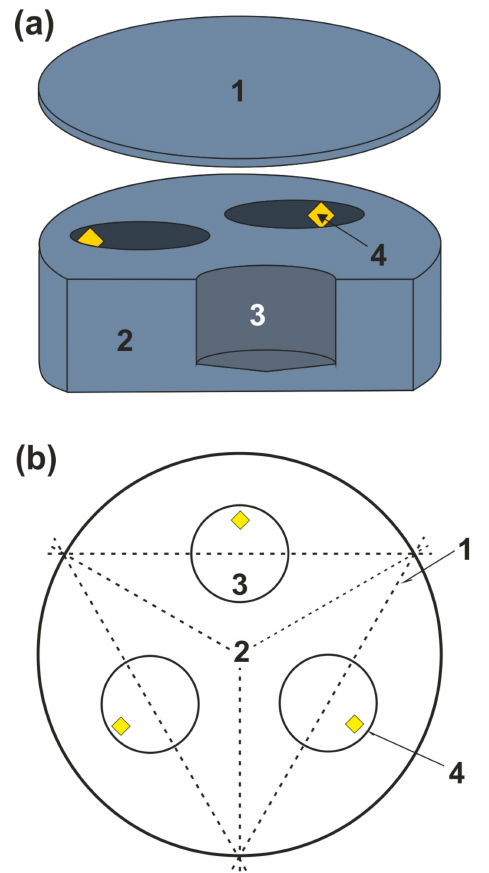
Figure 1. Scheme of a graphite capsule ( a ): 1—graphite cover; 2—graphite container with three blind holes; 3—sample volume; 4—diamond seed crystals; ( b )—Scheme for sawing of samples (top